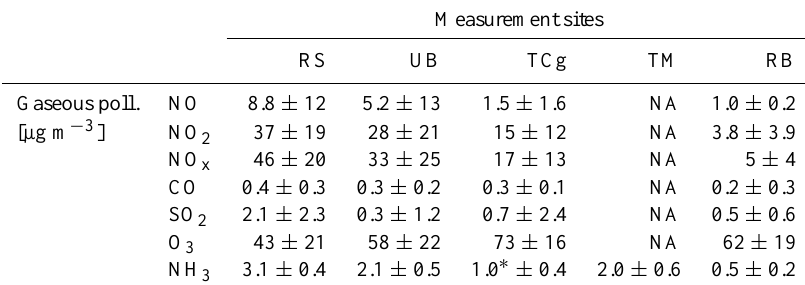
Table 4. Average gaseous concentrations at different sites during SAPUSS (NA: not available). * Average between TC (1.0 ± 0.4) and TCg (1.1 ± 0.4).